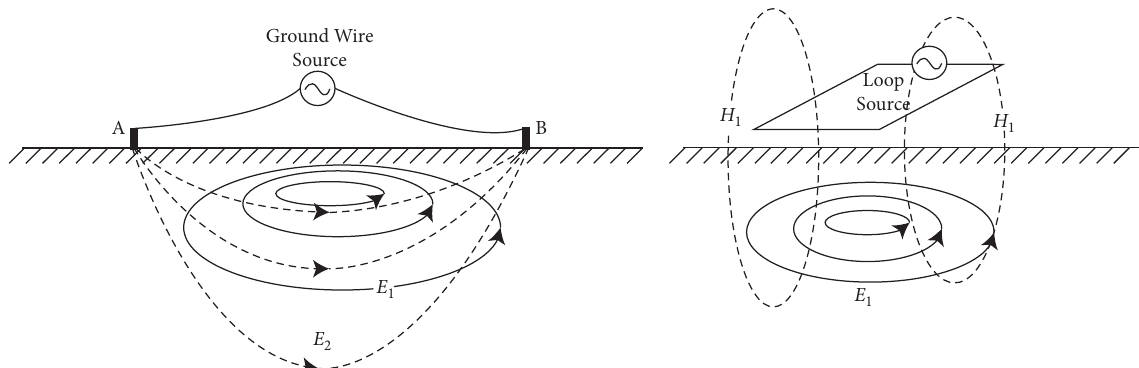
Figure 3: Comparison of the underground current distribution stimulated by the ground wire source and the loop source in a uniform half space; the left diagram is simulated by using a ground wire source, whereas the right diagram is simulated by using a loop source. (E)1 represents horizontal current, (E)2 represents vertical induced current, and (H)1 represents vertical magnetic